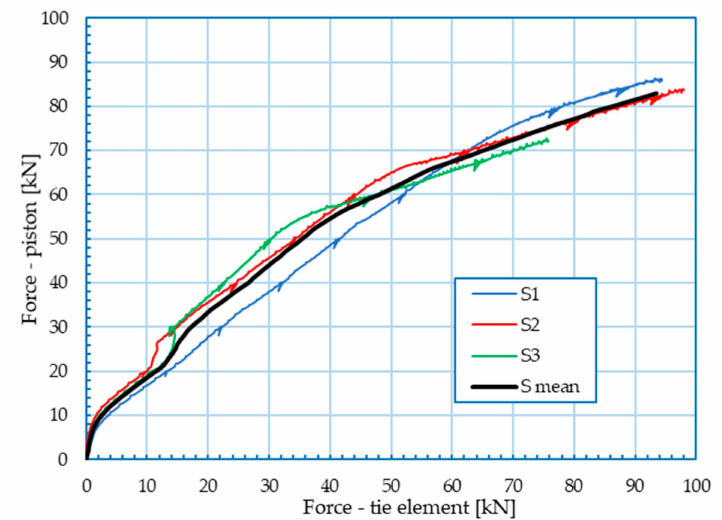
Figure 11. Force in the piston-force in the tie element